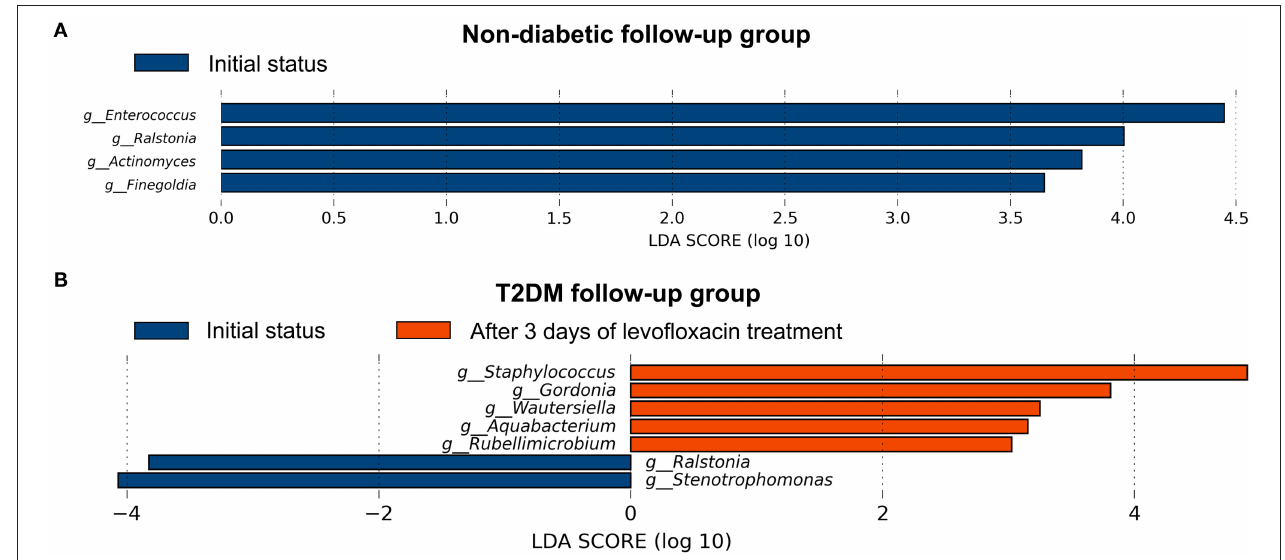
FIGURE 4 | Distinct alternations of conjunctival microbiota in response to levofloxacin eye drops based on LEfSe analysis at genus level. The statistically different genus in the ocular surface of the non-diabetic (A) and T2DM follow-up groups (B) , respectively. Positive linear discriminant analysis (LDA) score means the genus was more enriched before than after levofloxacin, while negative score means the genus was more enriched after than before